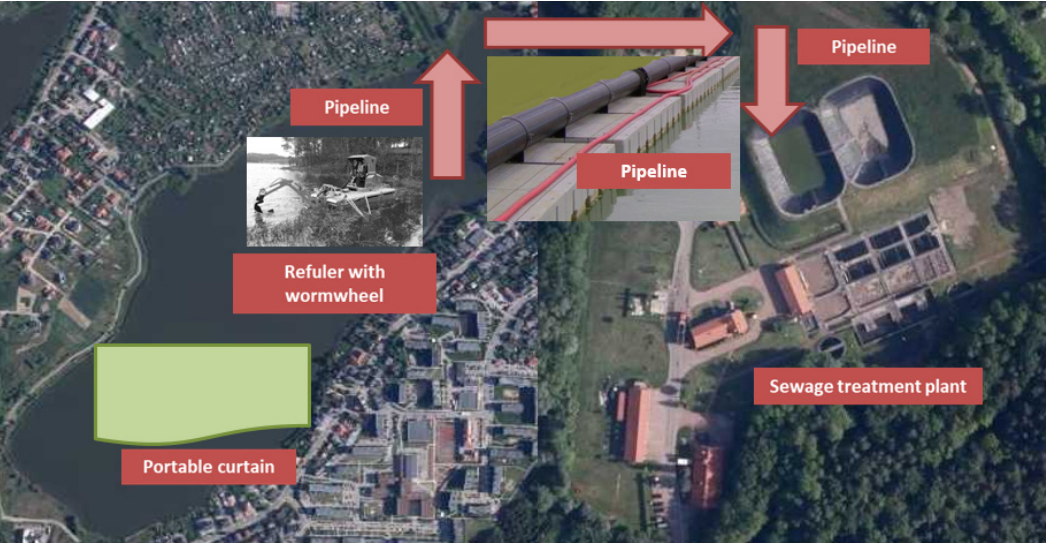
Figure 10. The scheme of planned restoration .